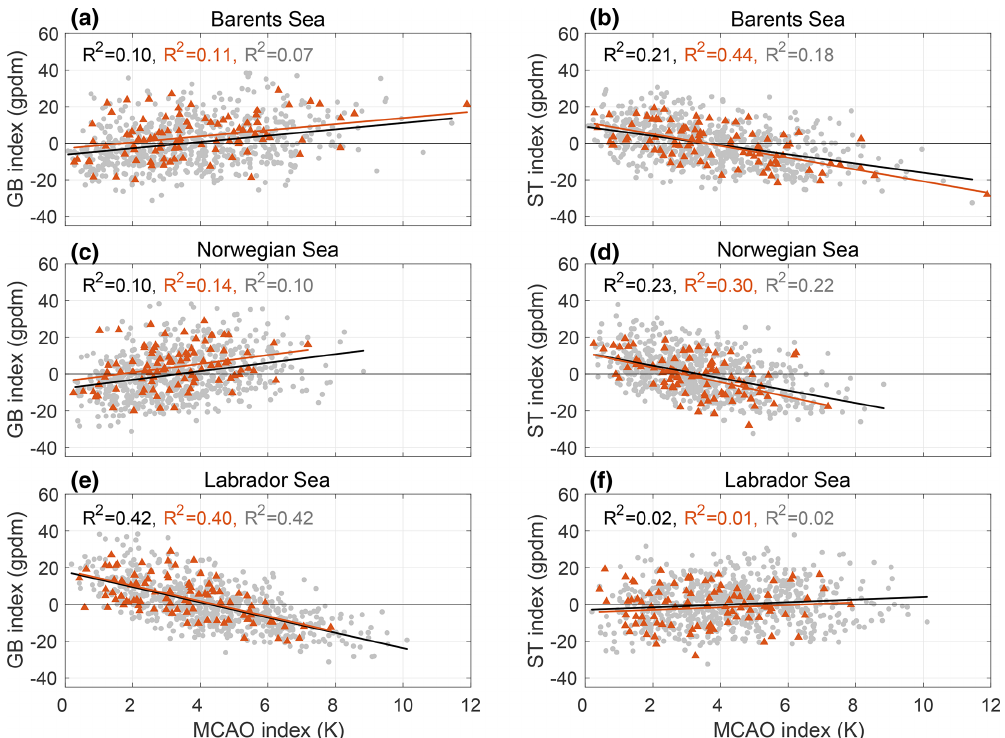
Figure 4. Same as Fig. 3, but for geopotential height anomalies (gpdm) averaged over (a, c, e) GB and (b, d, f) ST regions (green boxes in Fig. 2d, corresponding to the Z (cid:48) and Z (cid:48) , respectively) for (a, b) the Barents Sea, (c, d) Norwegian Sea and (e, f) Labrador Sea regions. GB ST All correlations are statistically significant ( p < 0 . 05).